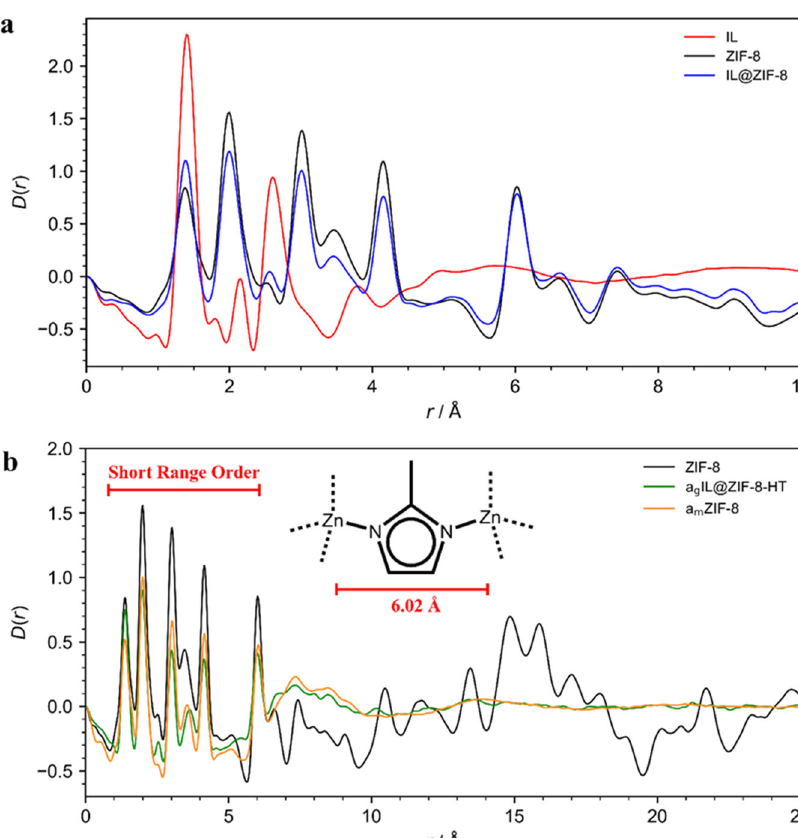
Fig. 8 Ambient temperature X-ray pair distribution function data. a Comparison of the X-ray pair distribution functions, D(r) of IL@ZIF-8 with its constituent components. b Comparison of the X-ray pair distribution functions, D(r) of a g (IL@ZIF-8-HT), ZIF-8, and a m ZIF-8. The limit of short-range order is shown along with the chemical connectivity of the ZIF-8 structure which accounts for the correlations within this